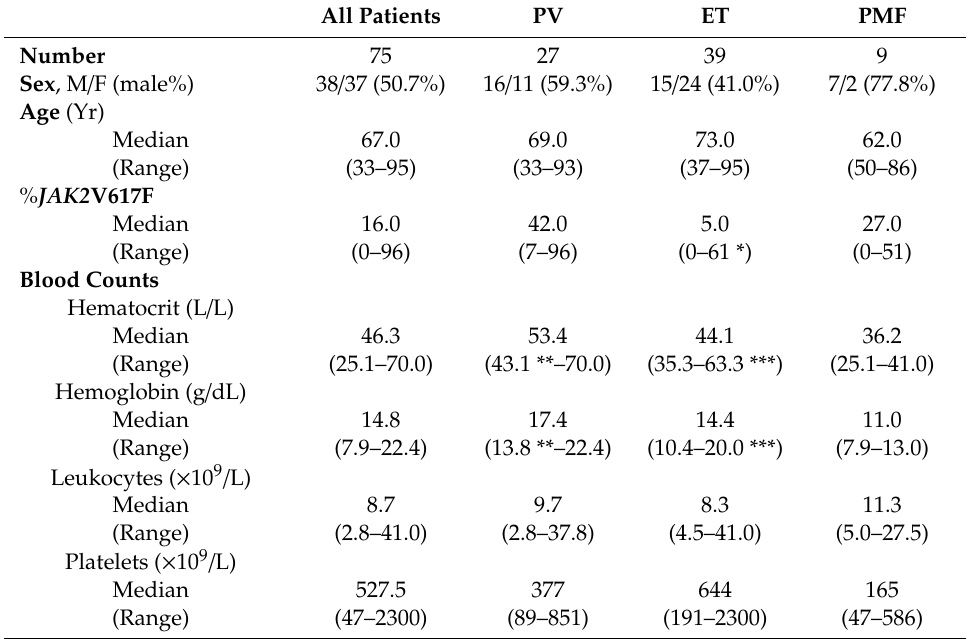
Table 1. Characteristics of myeloproliferative neoplasm (MPN) Patients.